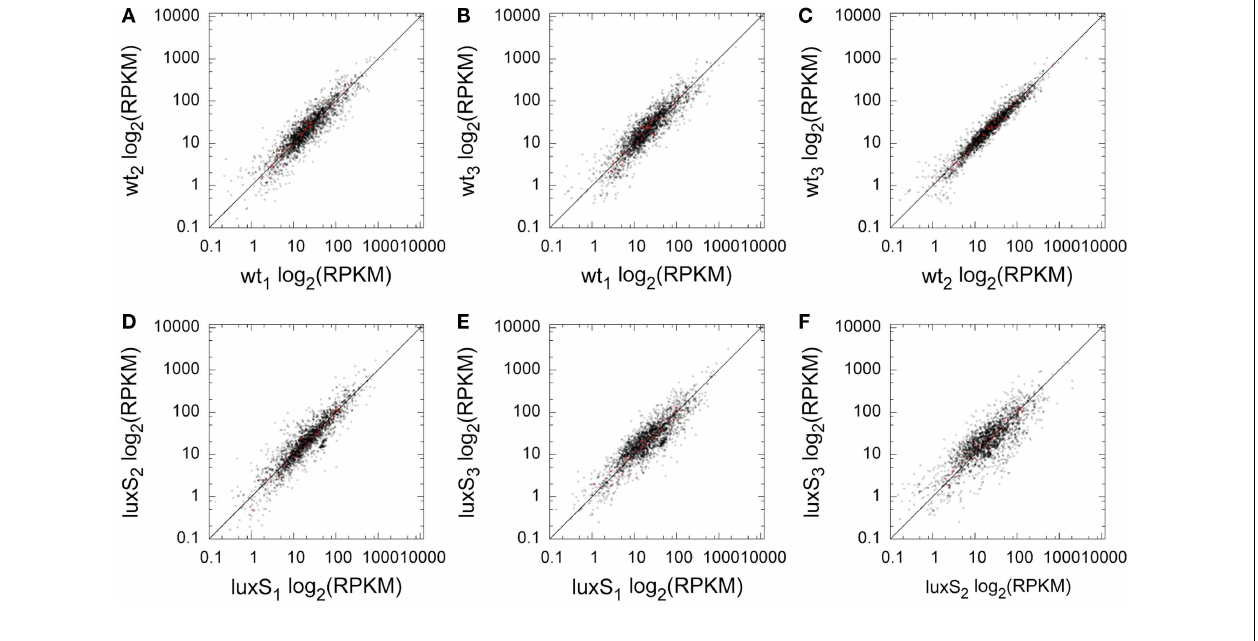
vs.WT3, (D) ∆ luxS 1 vs. ∆ luxS 2, (E) ∆ luxS 1 vs. ∆ luxS 3, (F) ∆ luxS 2 vs. ∆ luxS 3. Red colored data points indicate ORFs that demonstrated statistically significant relative abundance differences betweenWT and ∆